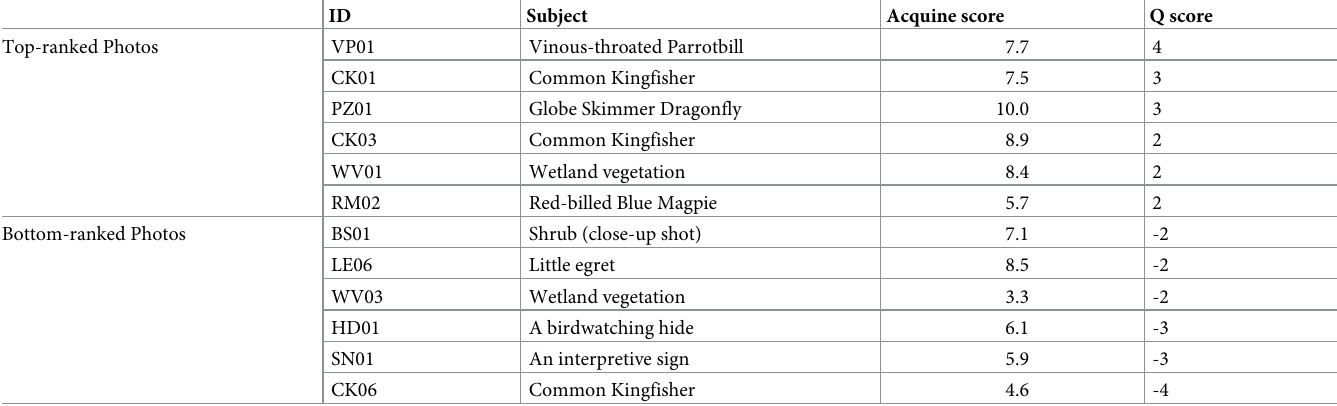
Table 6. The six top-ranked photographs (a) and the six bottom-ranked photographs (b) for Factor 4. ID Subject Q score Top-ranked Photos VP01